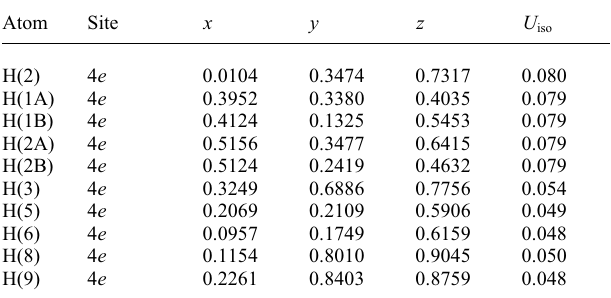
Table 2. Atomic coordinates and displacement parameters (in Å 2 ) .